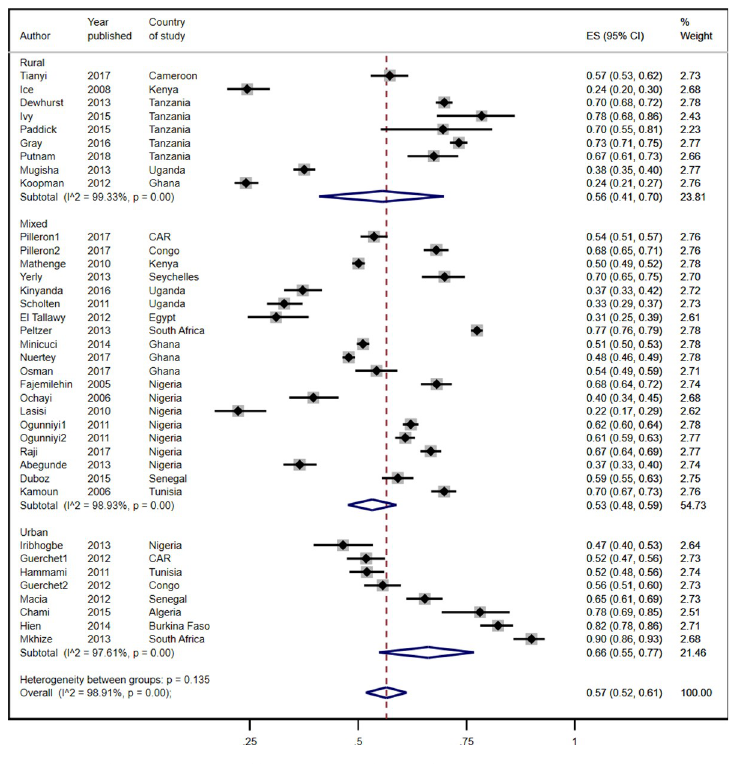
Fig 3. Prevalence estimates of hypertension by residence.